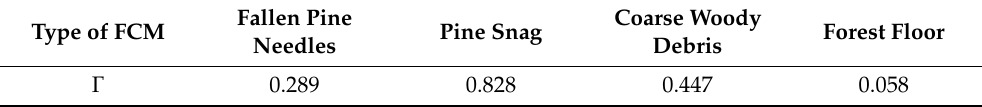
Table 3. Values of drying rate coefficient γ for some types of FCM.